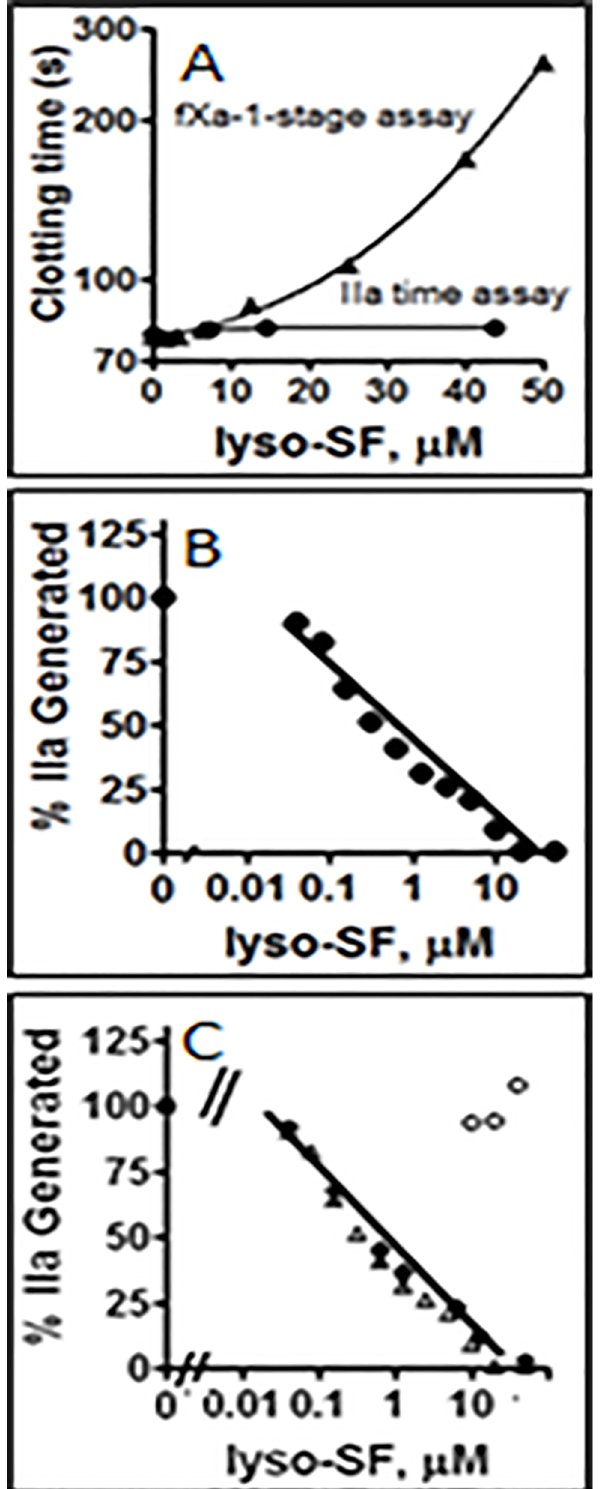
Fig 2. Inhibitory activity of lyso-SF. (A) Effects of Lyso-SF in plasma clotting assays: The effects of lyso-SF on fXa-initiated clotting assays (closed circles) or on IIa-initiated clotting assays (open circles). (B) Effect of Lyso-SF in II-ase assays: The effects of lyso-SF on IIa generation by the II-ase complex were tested in a